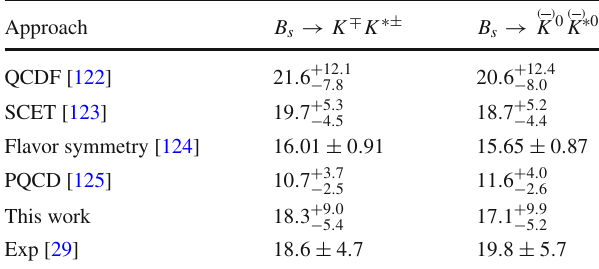
Table 2 The flavour-averaged branching ratios (in 10 − 6 ) of B → K K π decays with resonances K ∗ ( 892 ) , K ∗ PQCD approach, together with the experimental data